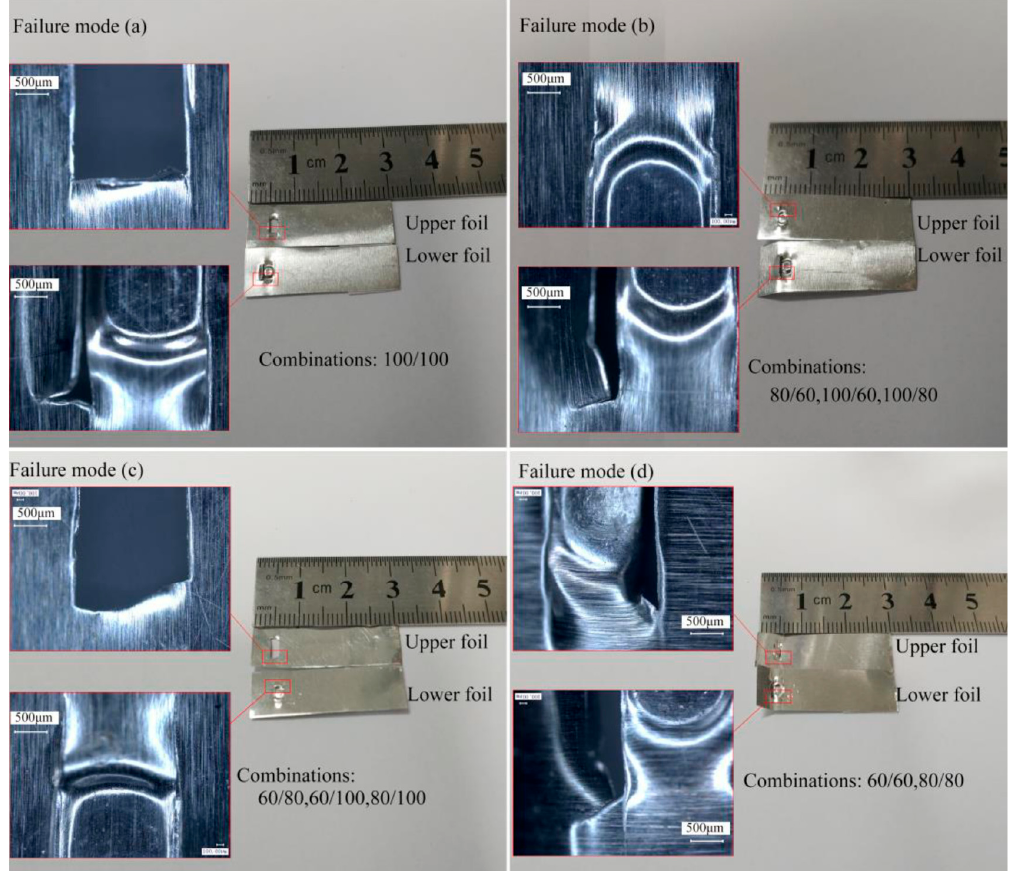
Figure 28. Four kinds of failure modes of perpendicular shear strength test.